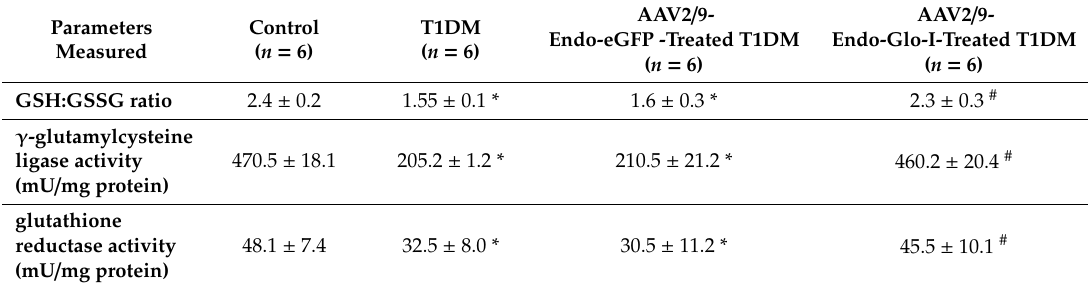
Table 2. GSH:GSSG ratios and activities of γ -glutamylcysteine ligase and glutathione reductase. Parameters